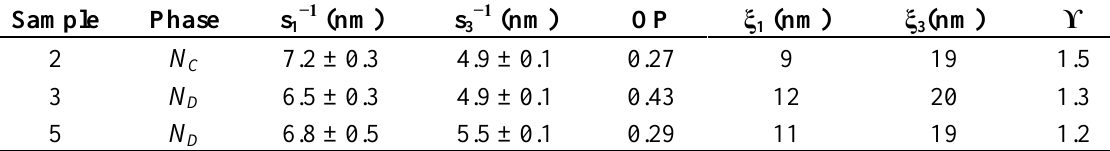
Table 1. X-ray diffraction data. s , i = 1,3 represents the moduli of the scattering vector that i correspond to the position of the diffraction bands along the horizontal (1-axis) and vertical (3-axis) directions of the laboratory frame axes. OP represents the order parameter, and ξ , i = 1,3 represents the correlation length corresponding to each diffraction band. i −1 /s −1 represents the average anisotropy of the available volume per micelle. ϒ = s 1 3